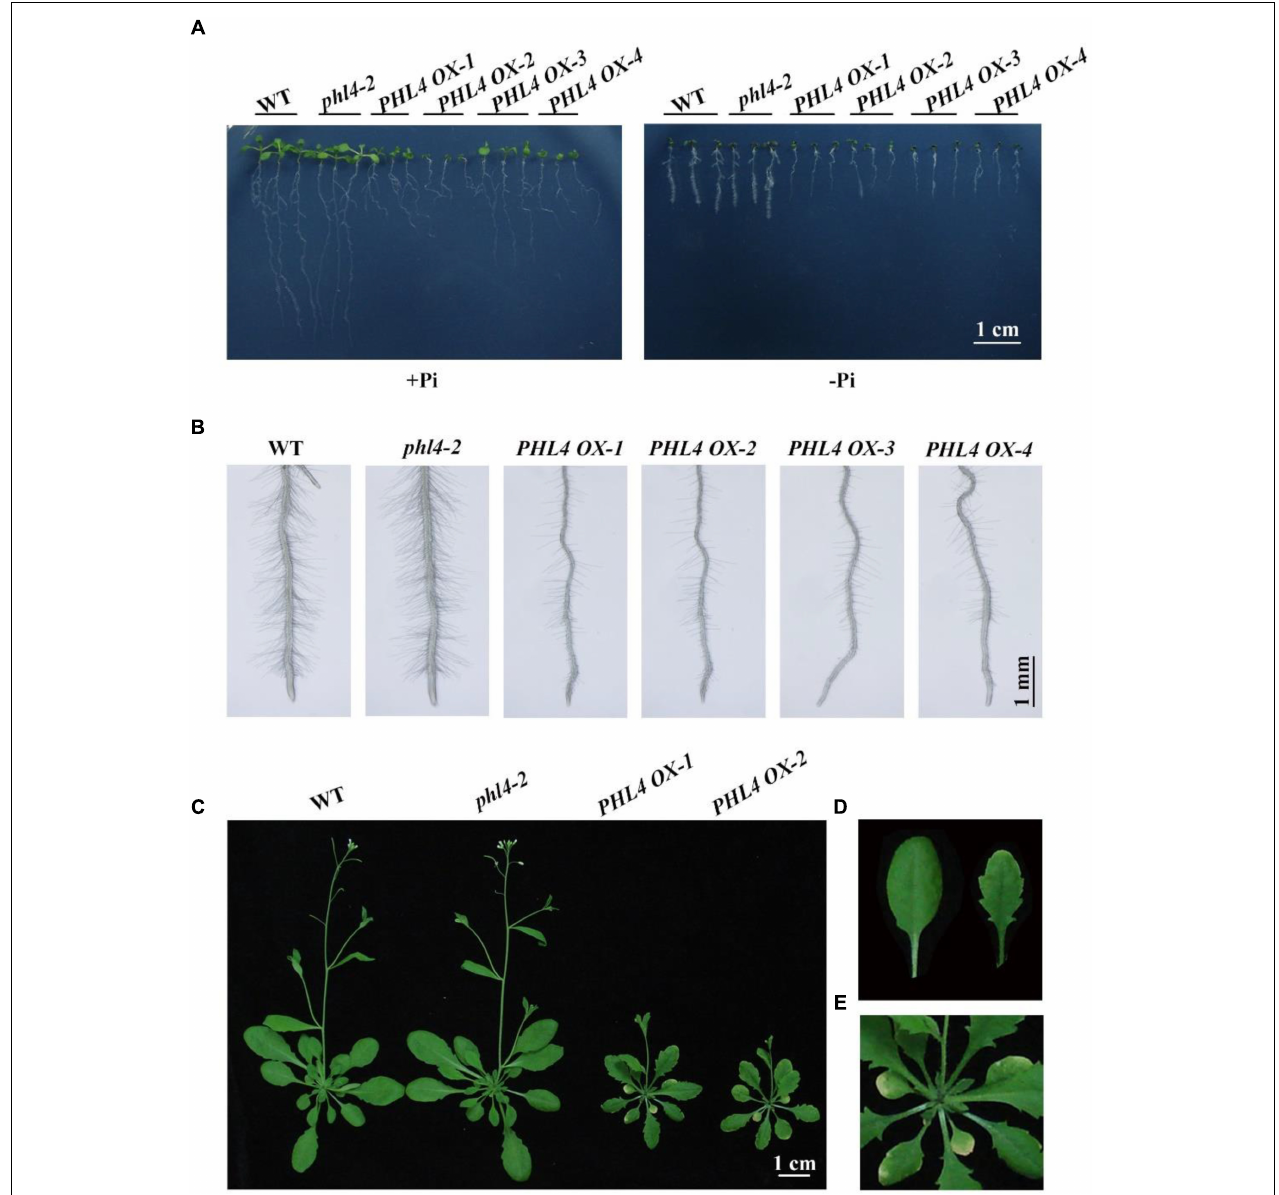
FIGURE 9 | Phenotypic analyses of the PHL4 -overexpression lines. (A) Morphology of 8-day-old seedlings of the WT, phl4 , and four PHL4 -overexpression lines grown on +Pi and –Pi media. (B) Root hairs of 6-day-old seedlings of the WT, phl4 , and four PHL4 -overexpression lines grown on –Pi medium. (C) Morphology of 5-week-old seedling of the WT, phl4 , and two PHL4 -overexpression lines grown in soil. (D) A comparison of the leaf edge of the WT and PHL4 OX-1 . (E) A close view of the rosette of PHL4 OX-1 .